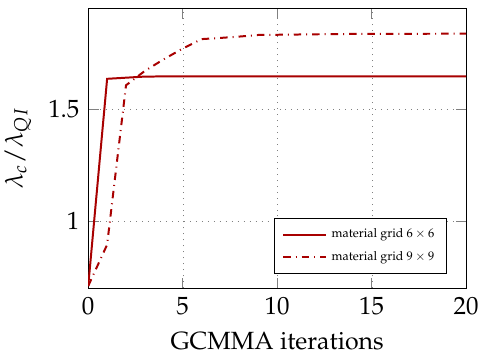
Figure 3. Convergence of the GCMMA optimisation algorithm at stage 1 for two different NURBS parameterizations of the lamination parameters.